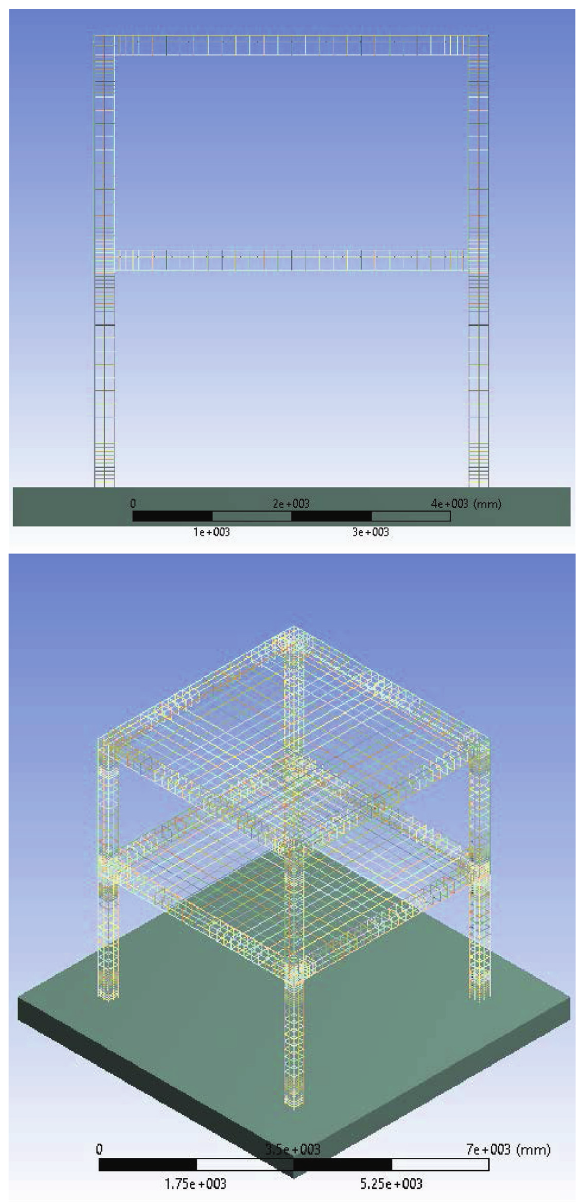
Figure 14: Reinforcement detailing for FRM_REI_DET_#2 on